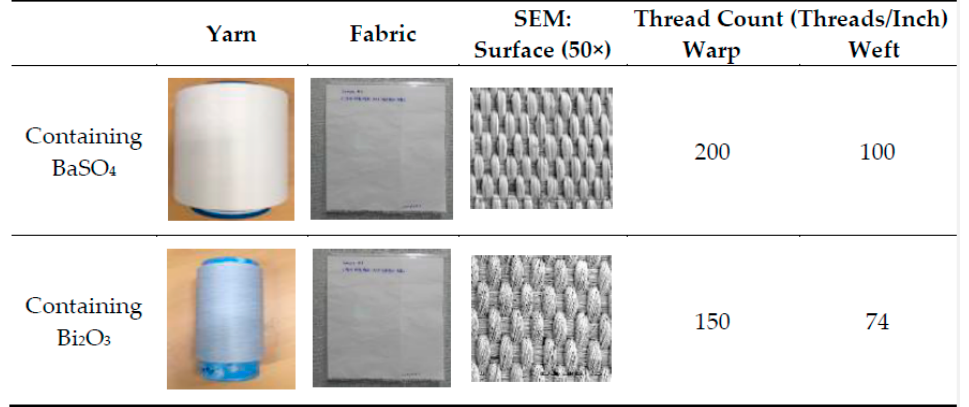
Figure 6. Conditions for weaving of the fabrics. Table 3. Characteristics of the shielding fiber fabrics.